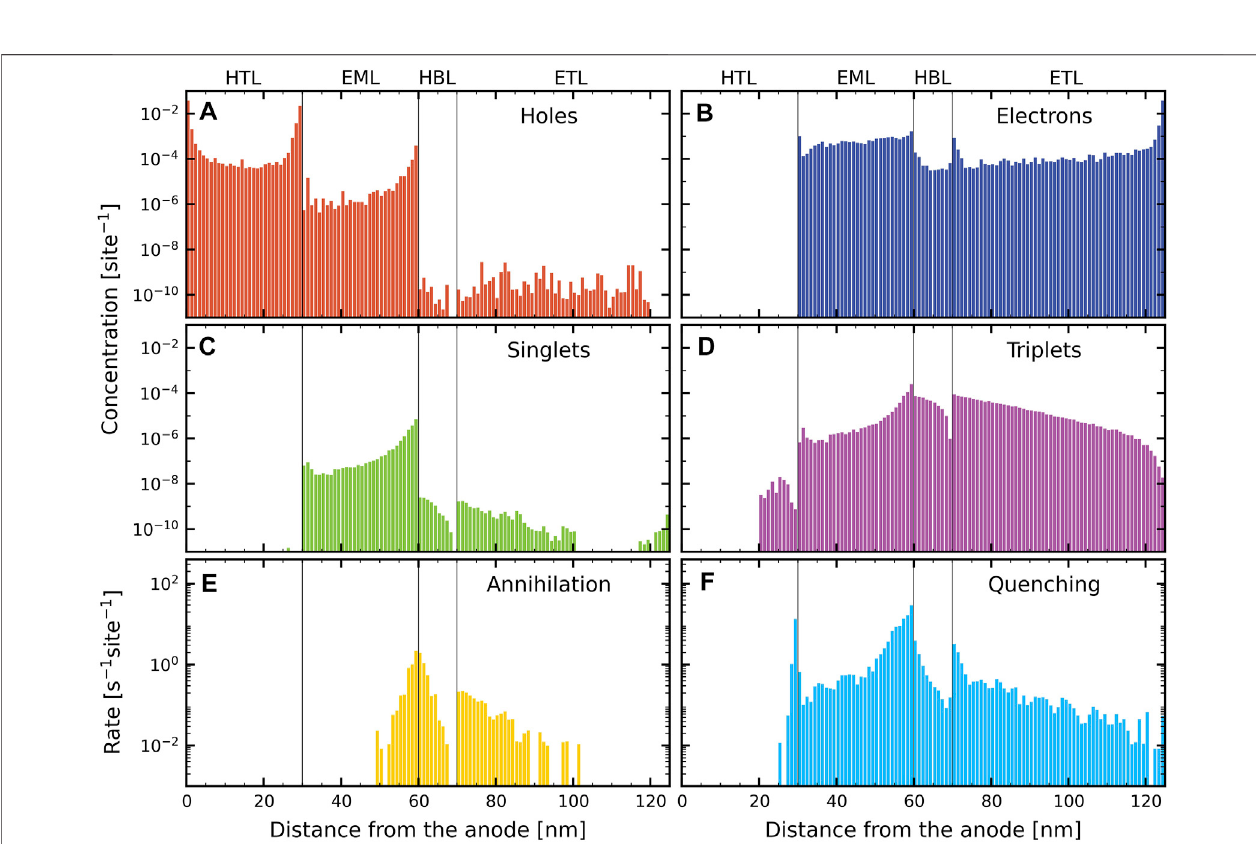
FIGURE 3 | Layer-resolved pro fi les, obtained from simulations of the pristine device and with Förster processes between all materials, at 9 V. (A) Hole concentration, (B) electron concentration, (C) singlet concentration, (D) triplet concentration, (E) annihilation rate (total for S – S, S – T, T – S and T – T annihilations), and (F) quenching rate (total for singlets and triplets with holes and